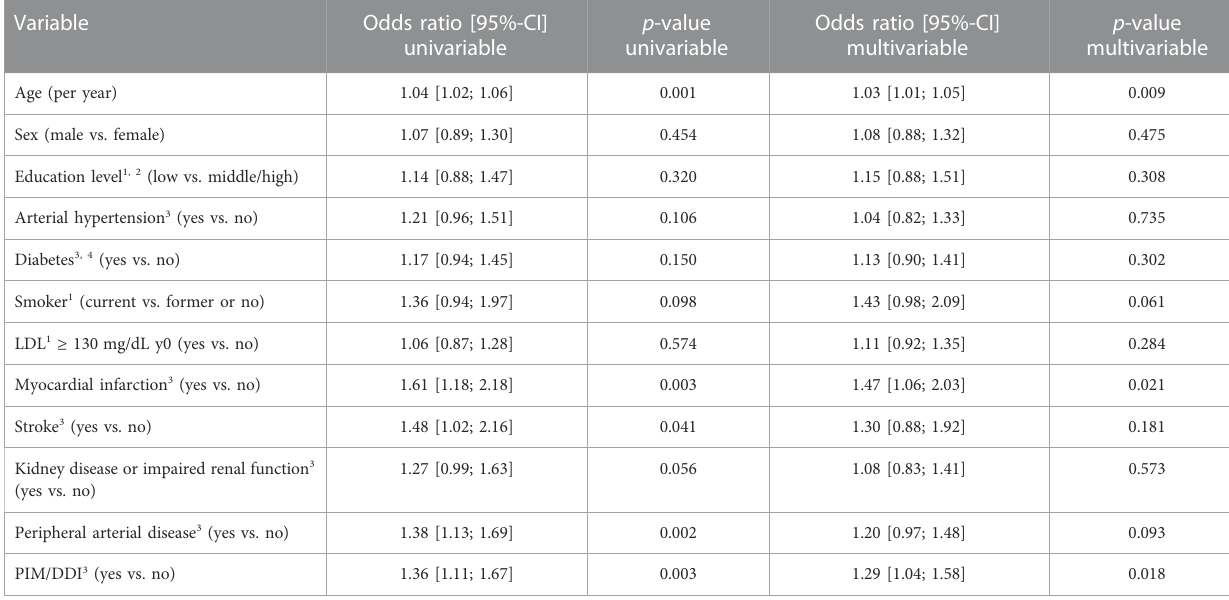
TABLE 3 Univariable models and multivariable model for the endpoint hospital admission (1,799 patients). Variable